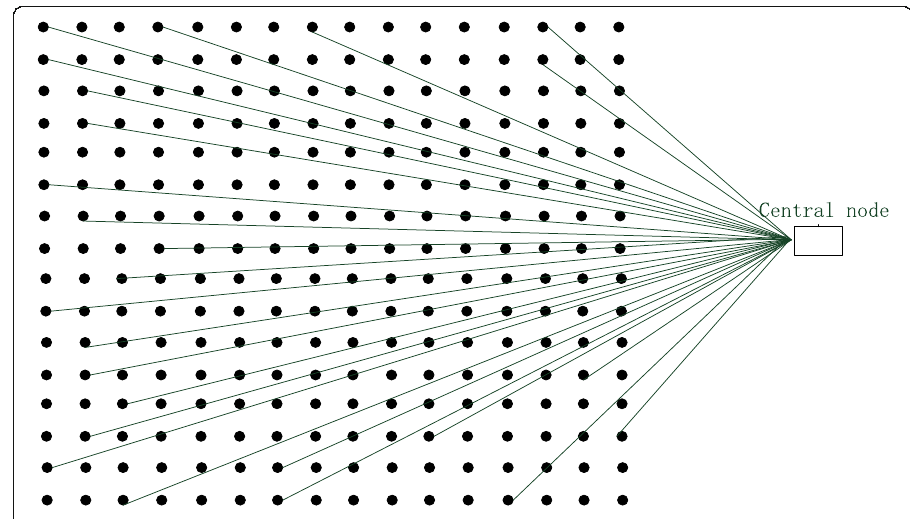
Fig. 1 Communication structure of wireless sensor